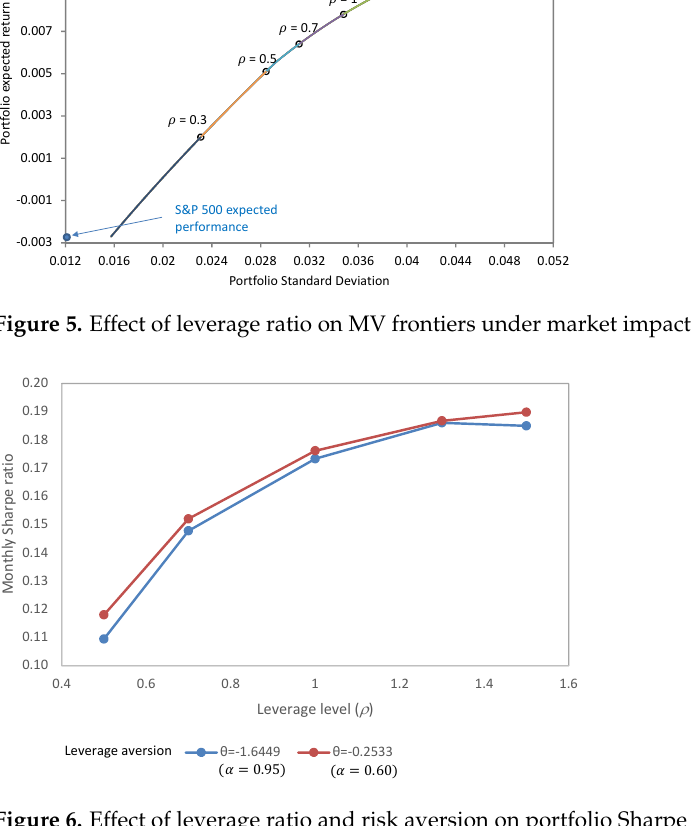
Figure 6. Effect of leverage ratio and risk aversion on portfolio Sharpe ratio under market impact. The trading losses associated with the MVL-efficient portfolios corresponding to the frontiers in Figure 5 are expressed as a fraction of the initial portfolio value, i.e., Π ( x ∗ ( m , ρ )) / A 0 , see (1). These slippage losses per unit of initial wealth are shown in 1 Figure 7. Quite interestingly, for sufficiently small target mean returns, the slippage loss fraction declines, and then it rises rapidly. This implies, under trading impact, that the practice of leveraging (in risk parity strategies) to increase target means results in increasing slippage loss rates quite drastically. The indicated declines in the loss rate, i.e., ‘downward branches’, are due to restricting leverage.